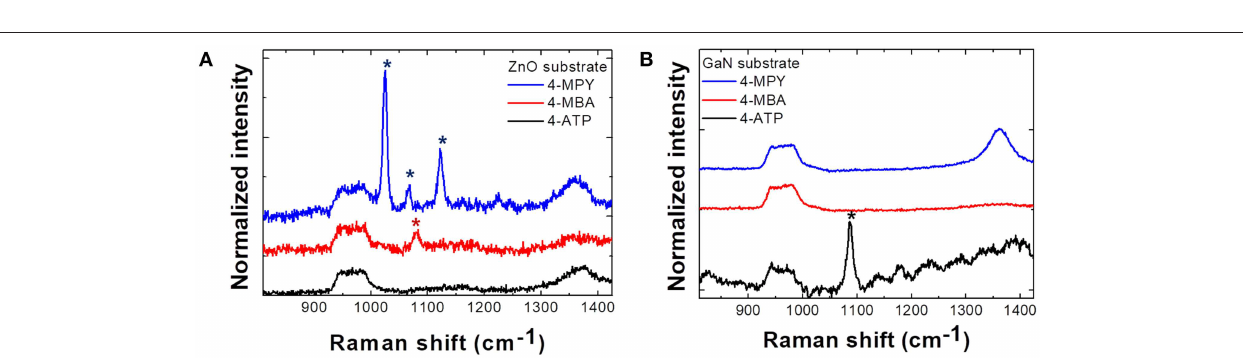
FIGURE 2 | Raman spectra of three different molecules (4-MPY, 4-MBA, 4-ATP) adsorbed on (A) ZnO microrod array substrate and (B) GaN microrod array substrate. Phonon intensity in each spectrum is normalized to Si phonon (520 cm − 1 ) intensity. Raman peaks of 4-MPY and 4-MBA molecules are enhanced only on the ZnO substrate and Raman peak of 4-ATP molecules is enhanced only on the GaN substrate. *Indicates the peak positions of each molecules (4-MPY, 4-MBA, 4-ATP).